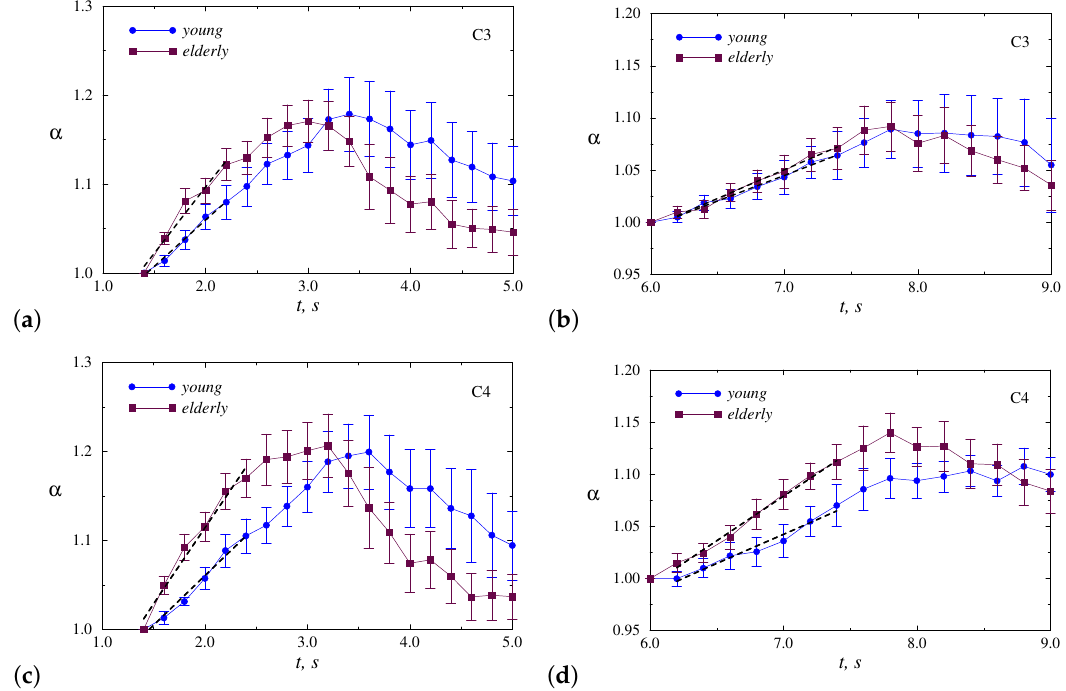
Figure 5. Normalized dependencies α ( t ) averaged over motor tasks executed by the dominant hand (RH), which are presented for two segments: clenching ( a , c ) and unclenching ( b , d ) the hand. The results are shown for the channels C 3 ( a , b ) and C 4 ( c , d